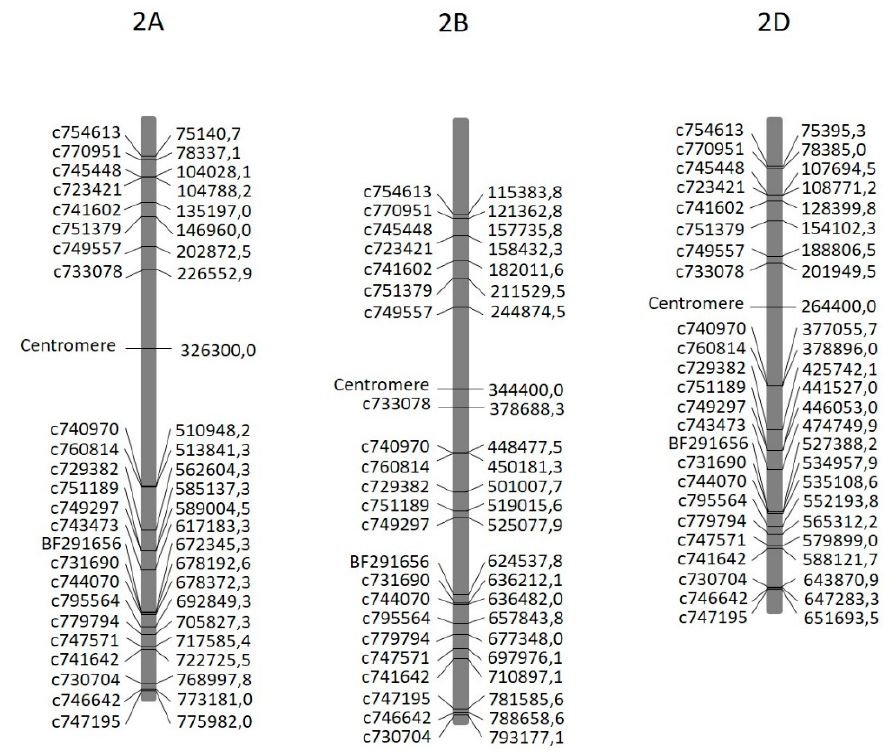
Figure 4. Visualization of wheat- H. chilense orthologous regions from the perspective of wheat homoeologous chromosome group 2. Physical map of the source expressed sequence tags (ESTs) of the COS-markers (left), the genomic positions on wheat pseudomolecules (kb) are on the right.